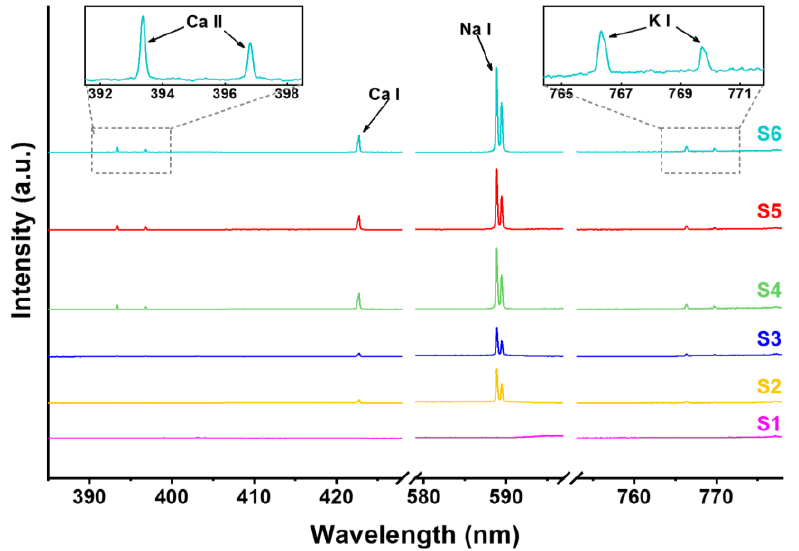
Figure 5. The negatively chirped FIBS spectra for six representative water samples: (S 1 ) Watsons, (S 2 ) Nongfu Spring, (S 3 ) Quanyangquan, and (S 4 ) tap water as well as the wild lake water from (S 5 ) Jingyuetan National Forest Park and (S 6 ) Nanhu Park in Changchun .